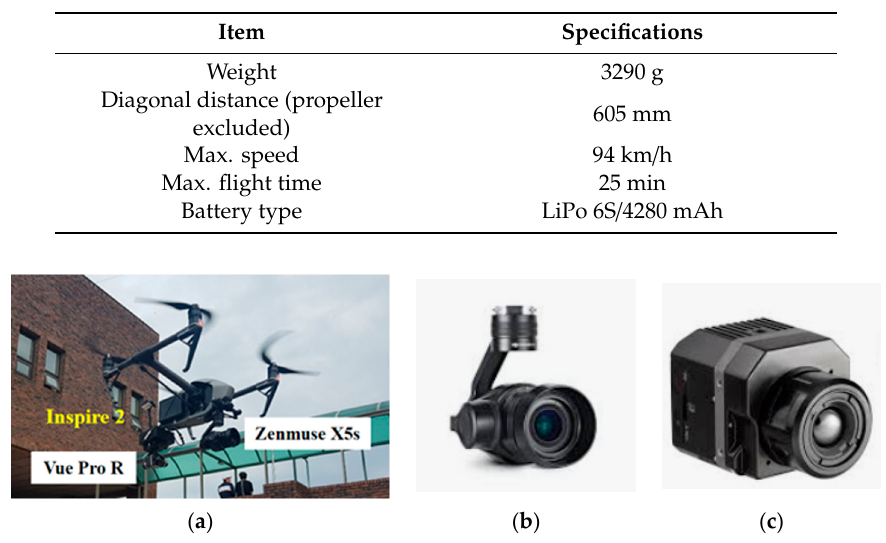
Figure 1. Location map of the Sooyoungro, Cheongju, Chungbuk in the Republic of Korea, which was photographed using unmanned aerial vehicles (UAVs) and optical sensor.